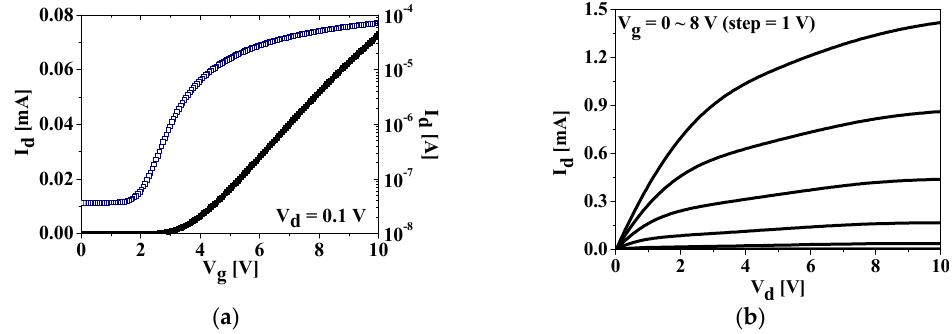
Figure 2. ( a ) Linear (filled black) and logarithmic (empty blue) scale of I d versus V g at V d = 0.1 V and ( b ) I d -V d curves sweeping V d = 0 ~ 10 V in the fabricated GaN MISFET.